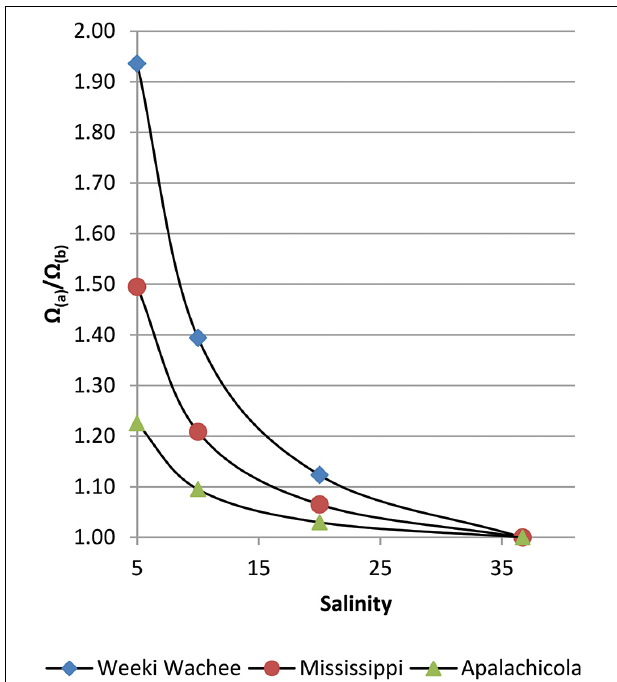
FIGURE 2 | Salinity versus (cid:127) ( A ) / (cid:127) ( B ) for three rivers that discharge into the Gulf of Mexico; the seawater end-member (S ∼= 37) is for the Loop Current (Wang et al., 2013). In addition to highlighting differences among river regions, this graph reveals an increasing disparity, as salinity decreases, between models that do and do not account for riverine [Ca 2 +